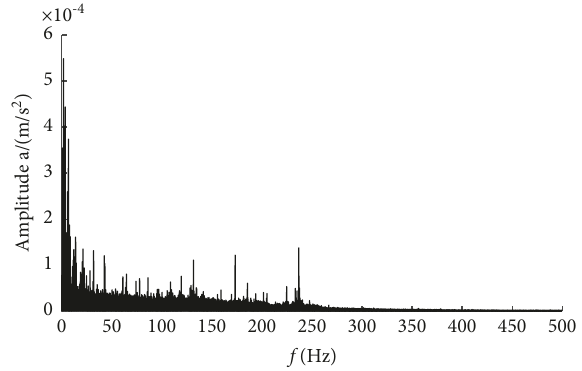
Figure 16: The envelope spectrum of the first component derived from EEMD decomposition of a vibration signal from class